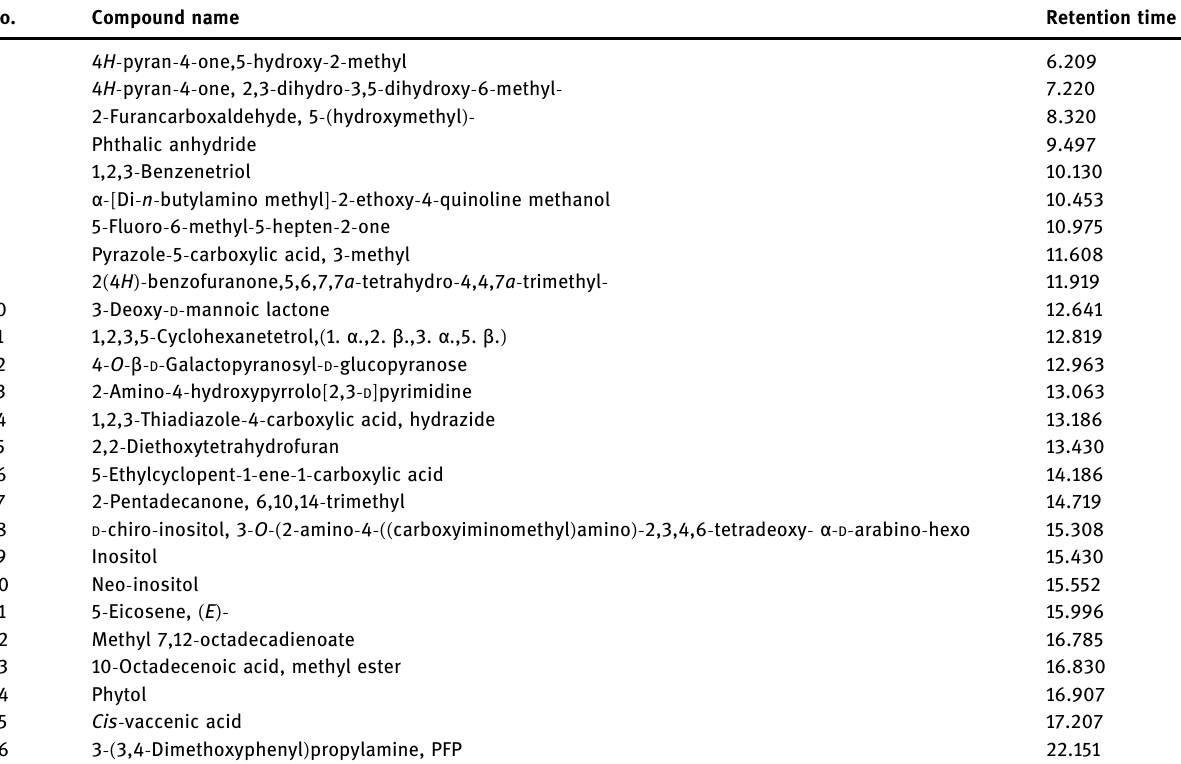
Table 2: GC - MS analysis of E. hirta